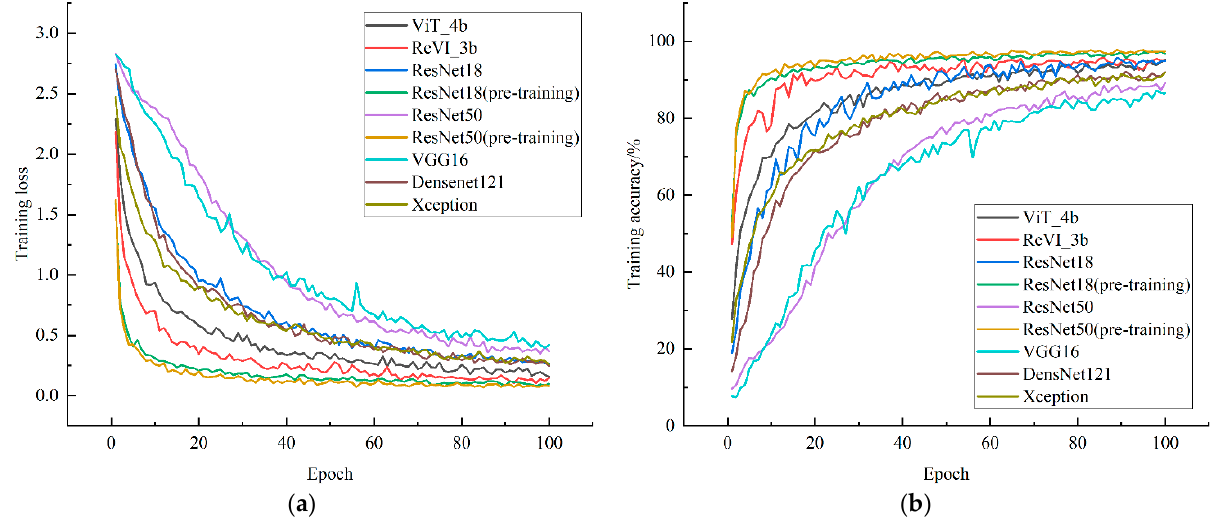
Figure 12. ( a ) Variation curves of loss for different deep models on the training dataset; ( b ) variation curves of accuracy for different deep models on the training dataset.